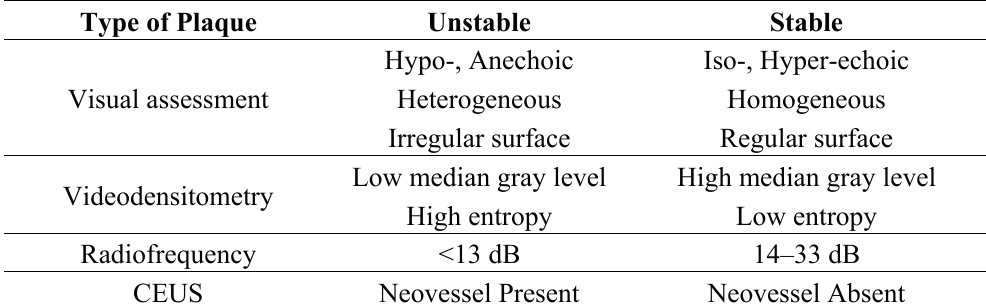
Table 3. Plaque imaging by ultrasound: criteria of instability.